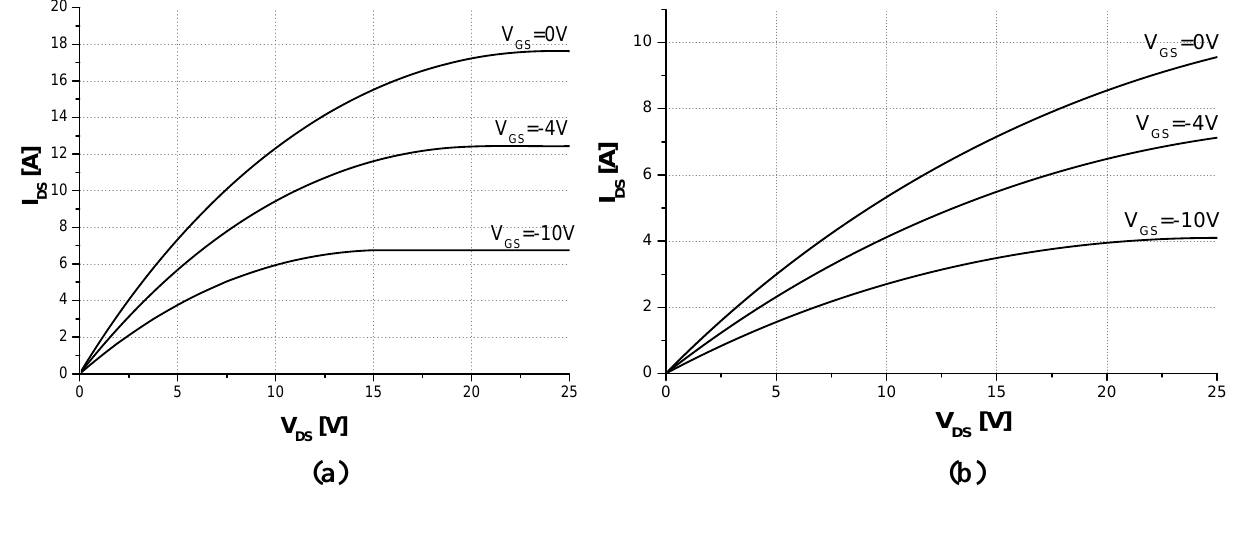
Figure 4. Simulation DC characteristics of the studied two channels SiC-JFET. (a) 300 K and (b) 500 K. (a = 0.46 µm, b = 0.76 µm, L = 5.7 µm, h = 1.05 µm, N = 1.3 × 10 16 cm –3 , W = 7.5 µm, L = 19 µm, Z = 3.8 N DV drift drift